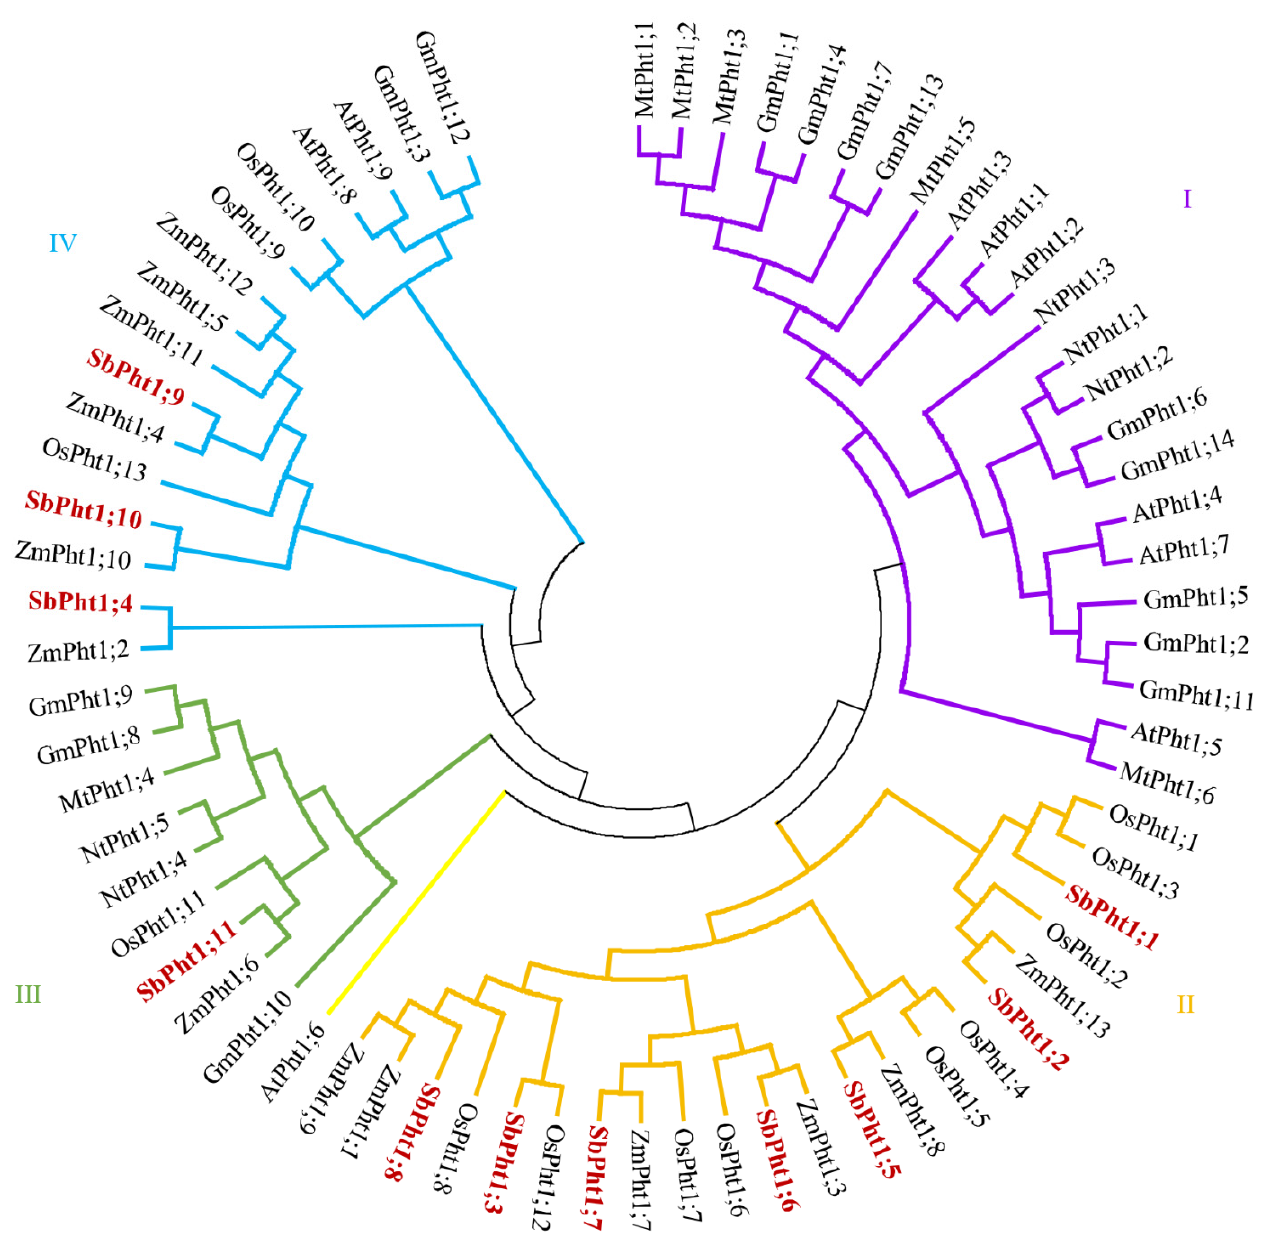
Figure 2. Phylogenetic analysis of Pht1. The phylogenetic analysis was based on the putative amino acid sequences of PTs deduced from their DNA sequences. The sequences retrieved from the NCBI GenBank are listed in Table S1.